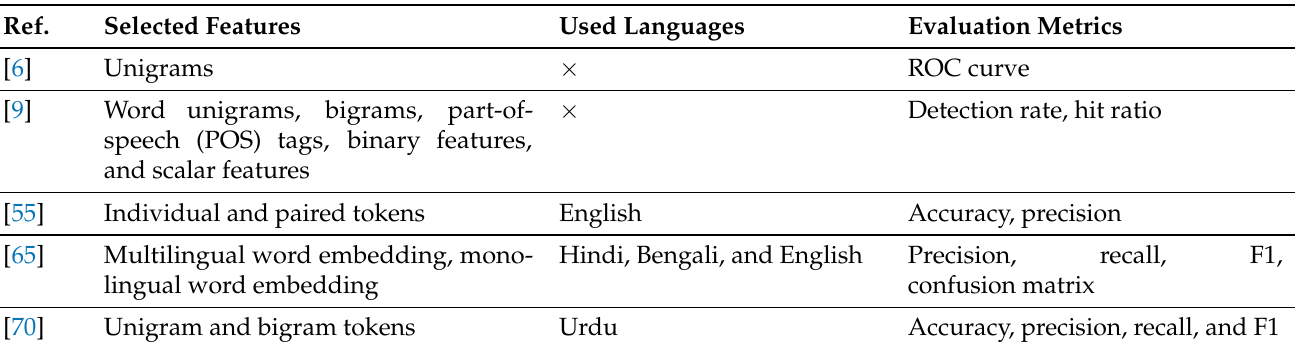
Table 2. A brief description of the selected features, studied languages, and evaluation matrices used in articles that applied deep ML